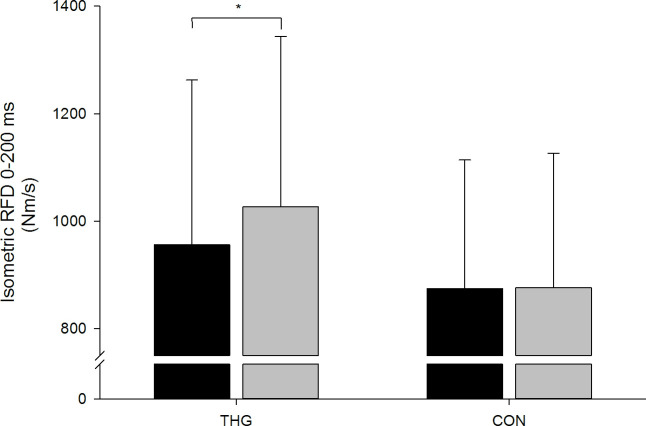
Late phase (0–200 ms) rate of force development (RFD).Late phase (0–200 ms) rate of force development (RFD) assessed during maximal isometric knee extensor strength (MVIC) testing at baseline (black columns) and following (grey columns) 12 wks small-sided team handball training (THG) or no training (CON). Data are presented as means ± standard deviation (SD). *Within-group different from baseline (p<0.05).